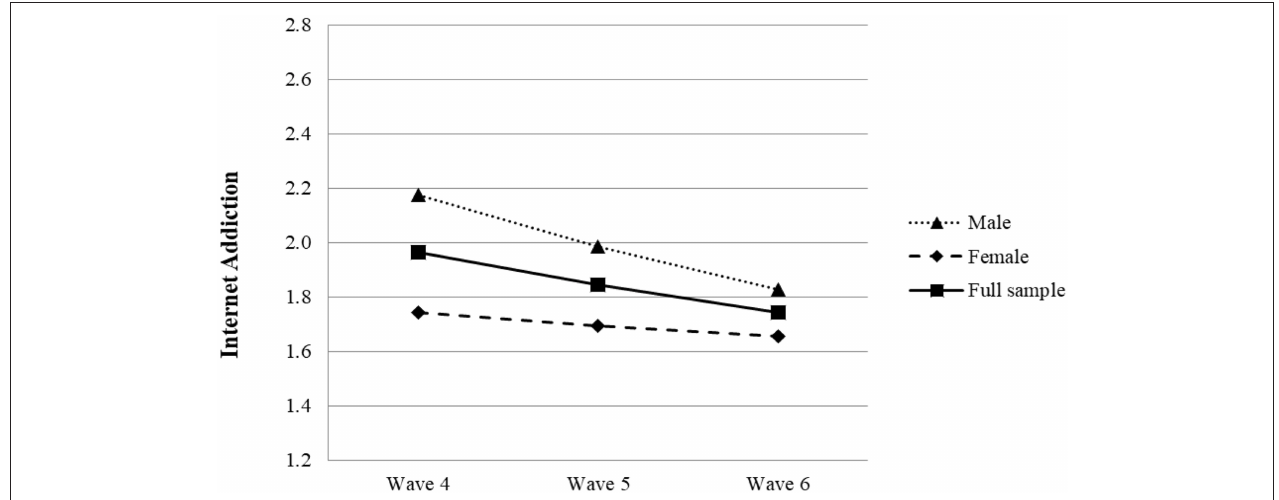
FIGURE 1 | Growth trajectories of adolescent Internet addiction as a function of gender. The figure for the full sample was plotted based on Model 2 shown in Table 5 . The figures for male and female samples were plotted based on results of gender-based analyses for Model 2 shown in Table 5 .